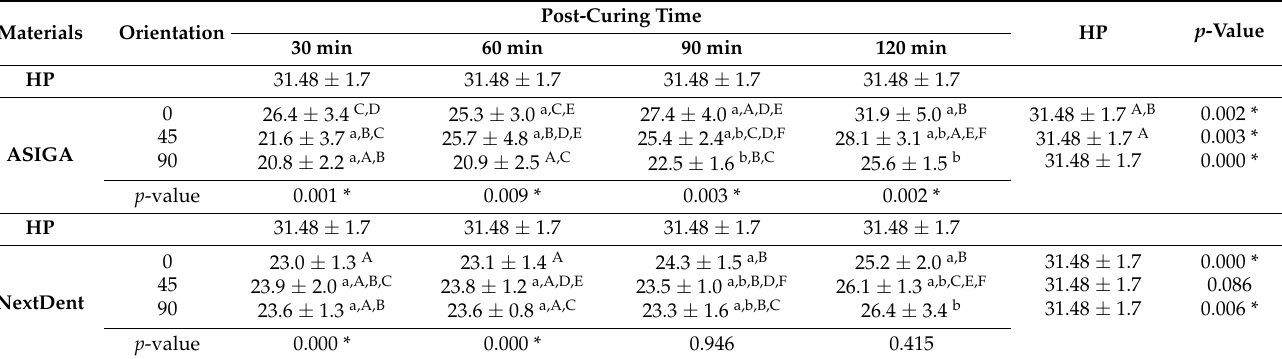
Table 3. Mean, SD, and significance of hardness (VHN) test between